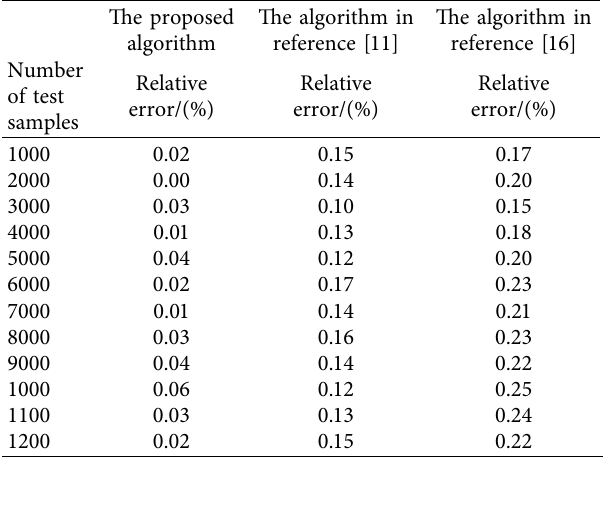
Table 3: Comparison of operation costs.